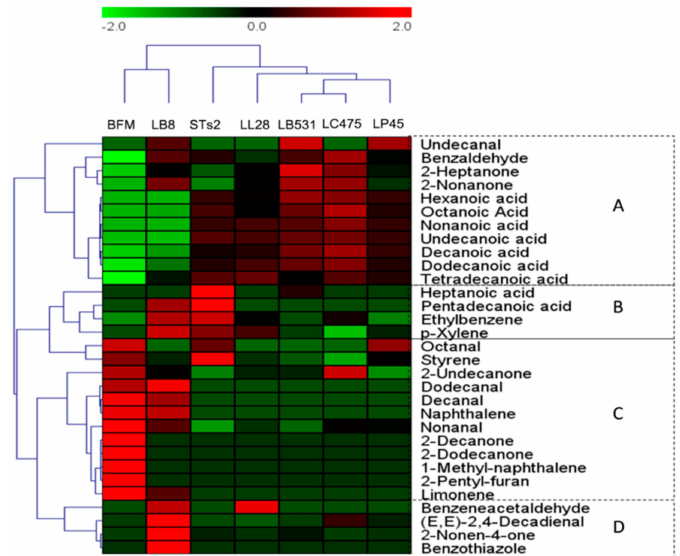
Figure 4. Heatmap of significantly di ff erent volatile compounds in the milks fermented by di ff erent starter cultures based on the OAVs. Green colors indicate that volatile compound levels were less than the mean levels, while red colors indicate that volatile compound levels were higher than the mean levels. Based on the OAVs, odor-active compounds were divided into four groups: A, B, C and